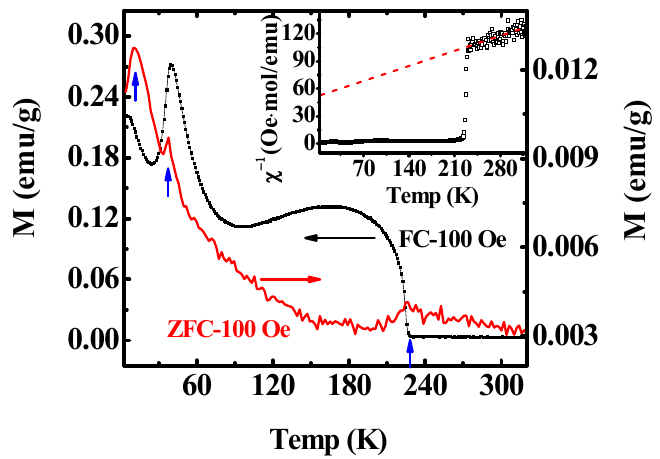
Figure 2. (Color online) Temperature-dependent magnetization curve of NdCrO 3 at the magnetic field of 100 Oe. The inset shows the reciprocal of the dc magnetic susceptibility vs. the temperature. Frequency dependence of the real part ( ε′ ) of the dielectric constant (Figure 3a) and the loss